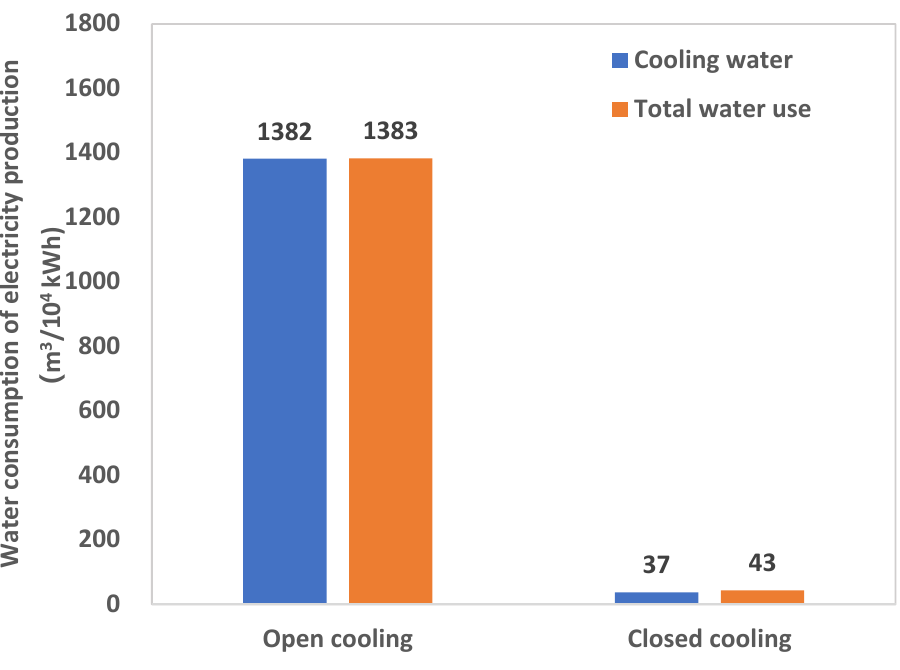
Figure 14. Water consumption of power plants using open and closed cooling systems.